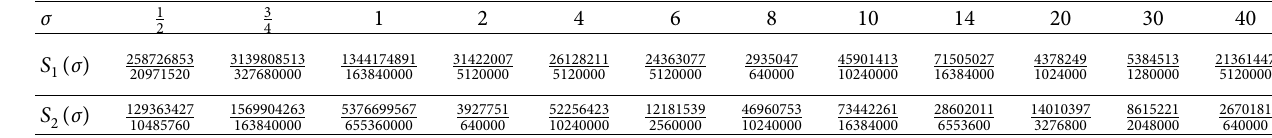
Figure 3: Graphics of H Table 3: More numerical results for S ( σ ) .